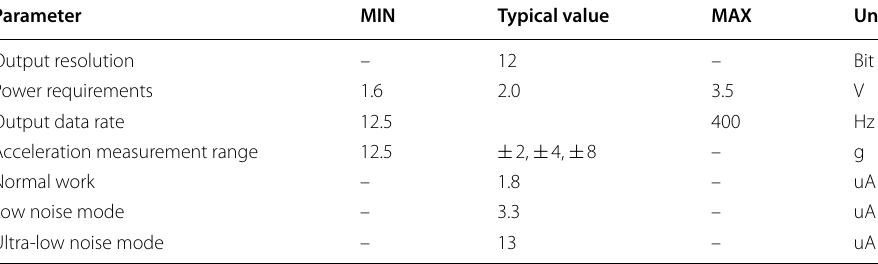
Table 1 ADXL363 main technical specifications and performance